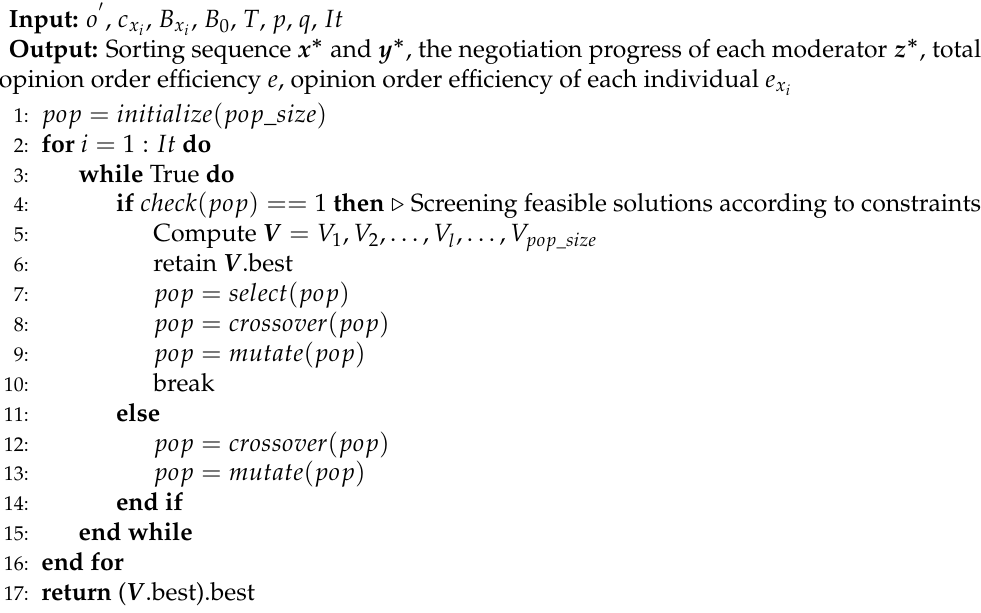
Algorithm 1 Algorithm to solve sorted negotiation